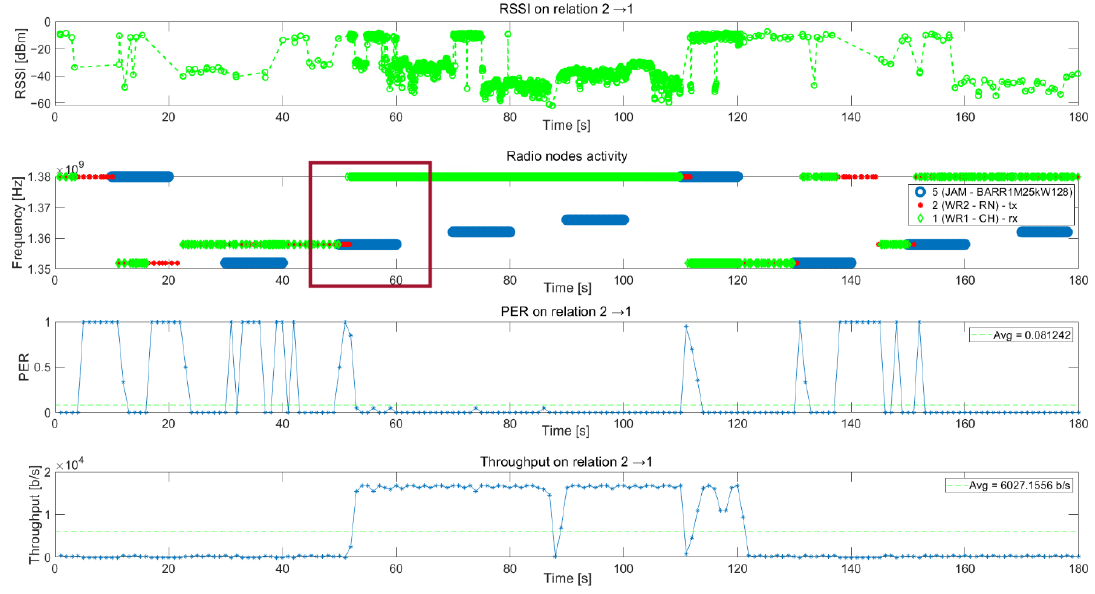
Figure 15. Metrics of transmission between node 2 (TX) and 1